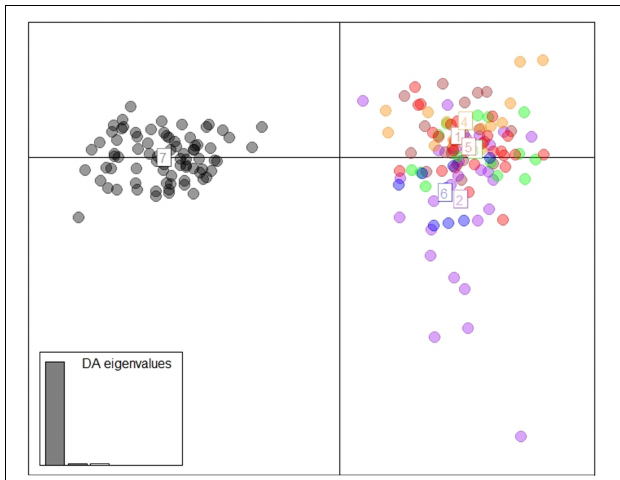
FIGURE 2 | DAPC using 1,494 neutral loci and 9 principle components. (1 = South Africa, 2 = Indonesia, 3 = Western Australia, 4 = Papua New Guinea, 5 = eastern Australia, 6 = New Caledonia, and 7 =